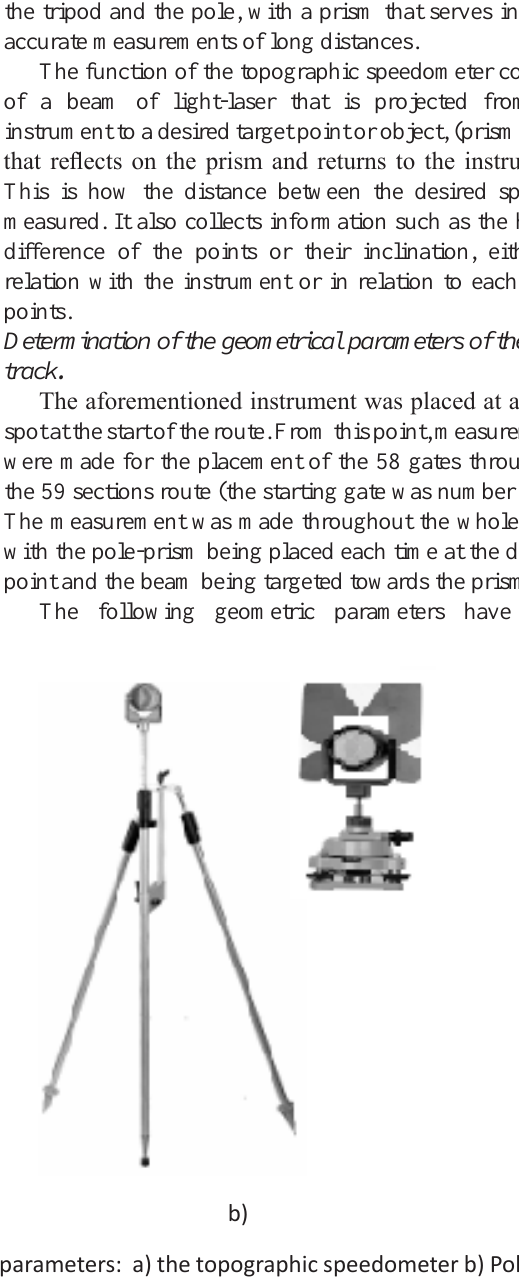
Figure 1. The instruments of measurement of the geometry parameters: a) the topographic speedometer b) Pole and prism